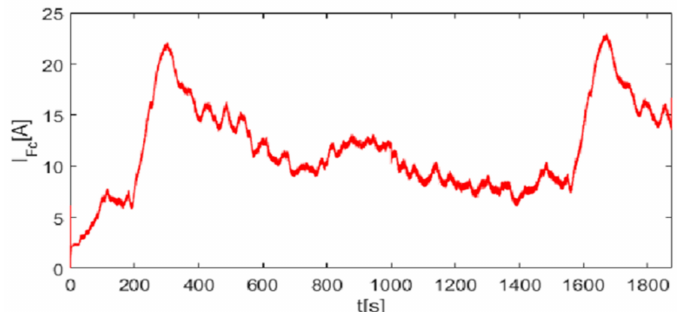
Figure 27. Current of the fuel cell.